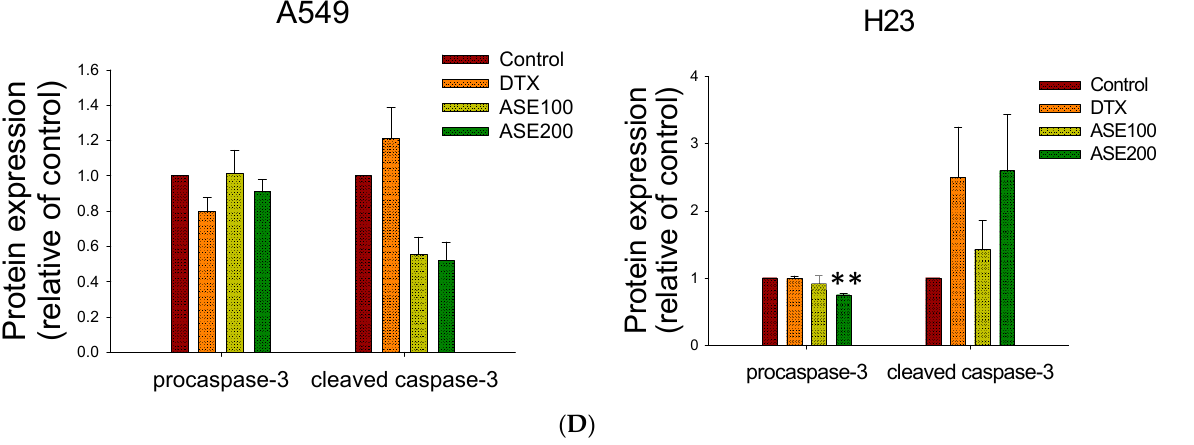
Figure 2. The ethanol extract of Artemisia santolinifolia (ASE) triggers different features of the cell death mode. Flow cytometry and Western blotting were performed to analyze the cell death mode following ASE and DTX treatment in A549 and H23 cells. ( A ) Apoptosis assay after staining with Annexin V-FITC/7-aminoactinomycin D (7-AAD). A549 and H23 cells were treated with 100 and 200 μ g/mL ASE or 0.5 nM DTX (the positive control) for 48 h. ( B ) Quantification of dead cells following ASE treatment. ( C ) Representative images of Western blot analysis of caspase-3 expression with the most significant alterations. β -actin was used as a loading control. ( D ) Histograms quantified Western blot results of three replicates. Data are the mean ± SE; ** p < 0.01 vs. the corresponding control.